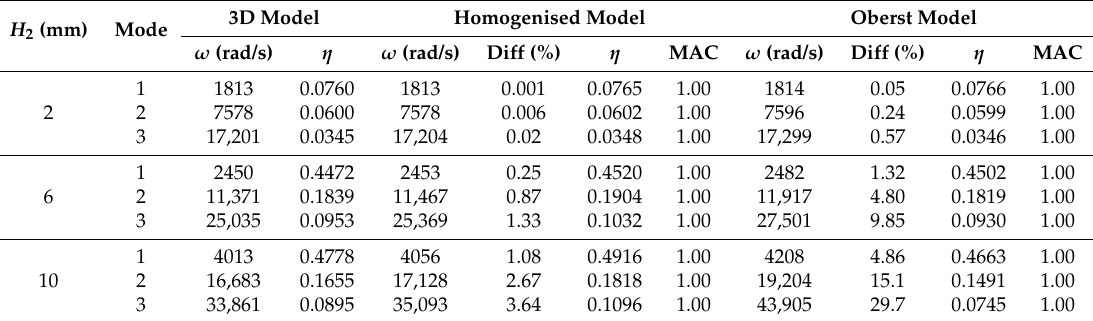
Table 1. Natural frequencies and loss factors of the simply supported FLD beam computed with the three models. For the beam models, the percent difference in the natural frequencies and MAC value in comparison to the 3D model are